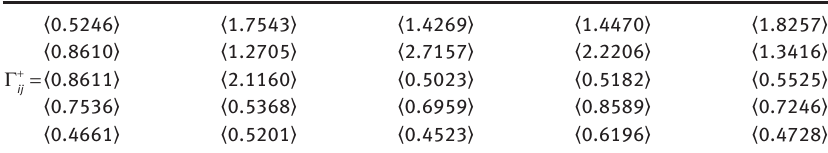
Table 16: The Gray Relational Coefficient of each Candidate from PIS.